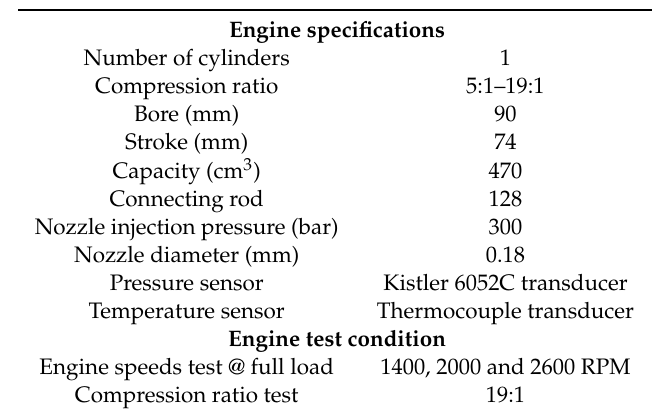
Figure 3. Schematic diagram of test set-up. Table 3. Engine specifications [5,6].